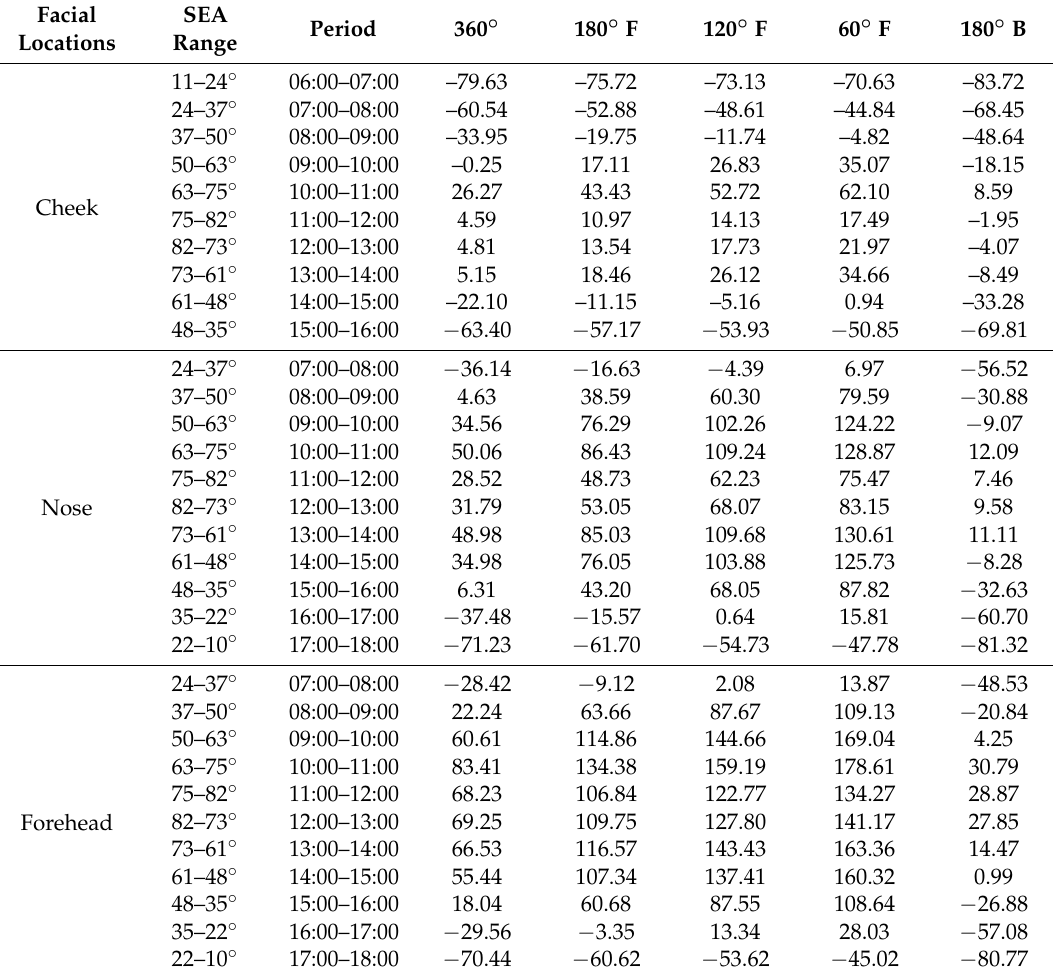
Table 2. The increasing or decreasing percentages of average 1 h cumulative cheek, nose, and